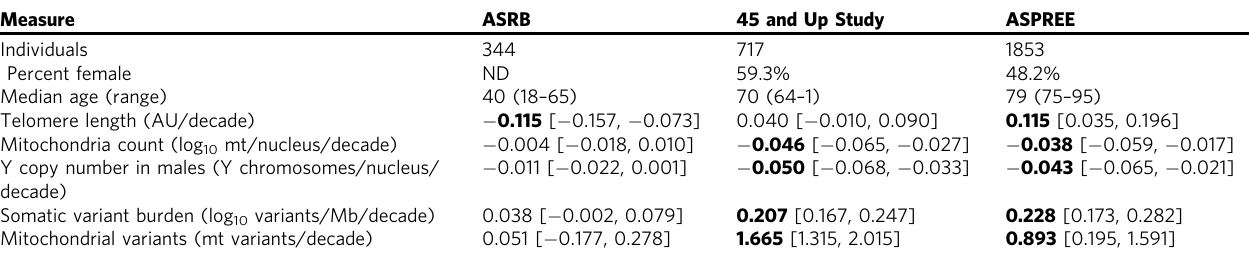
Numbers show the rate of change of each somatic measure with age in the middle-aged ASRB cohort (median age 40), and the older MGRB cohorts (median age 70 or older). Changes are signi fi cantly different between the younger ASRB and older MGRB cohorts, and consistent within the two older MGRB cohorts. Linear model slopes as change per decade are reported for each of fi ve somatic measures in each cohort, with 95% Wald con fi dence intervals. Values signi fi cantly different from zero are represented in bold. Note that somatic burden and mitochondrial count per nucleus are reported on the natural logarithm scale. ND, not determined due to data use agreement